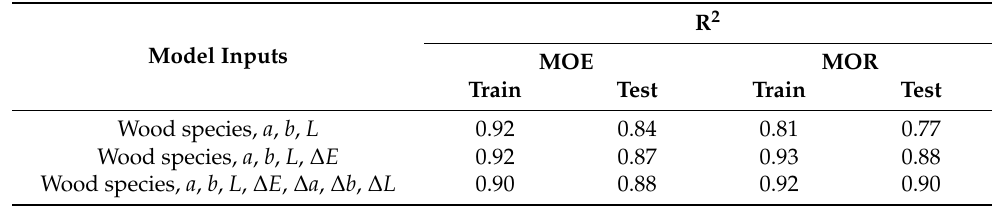
Table 2. The coefficient of determination obtained for the prediction of the wood mechanical properties using different input features.